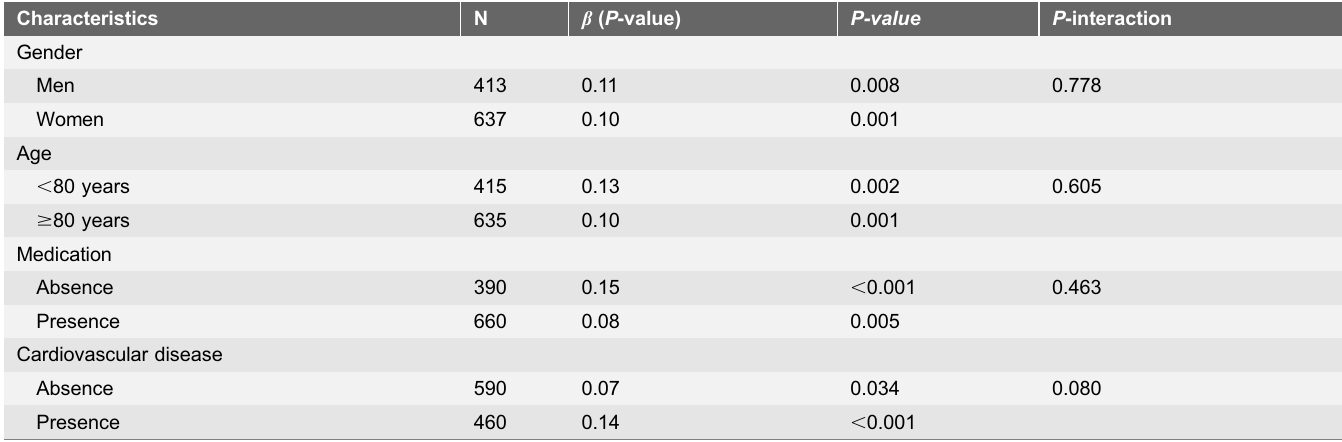
Table 5. Relationship between serum bilirubin and estimated glomerular filtration rate within selected subgroups.